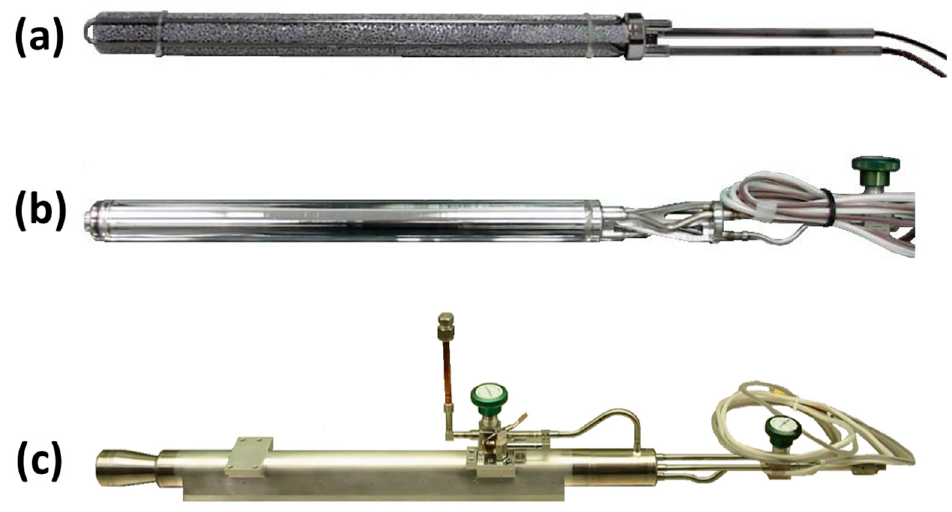
Figure 6. Photographs of ( a ) the porous Al metal foam and heater assembly of the inner hydride bed prior to insertion in to create the CE sorbent bed, ( b ) the CE hydride sorbent bed after filling with LaNi 4.78 Sn 0.22 alloy prior to insertion into Al outer shell, and ( c ) a complete flight-version Planck Sorption Cryocooler (PSC) Compressor Element (CE) containing an inner hydride sorbent bed and the gas-gap heat switch (GGHS) assembly (Adapted from Reference [32] (2019, with permission from Elsevier).